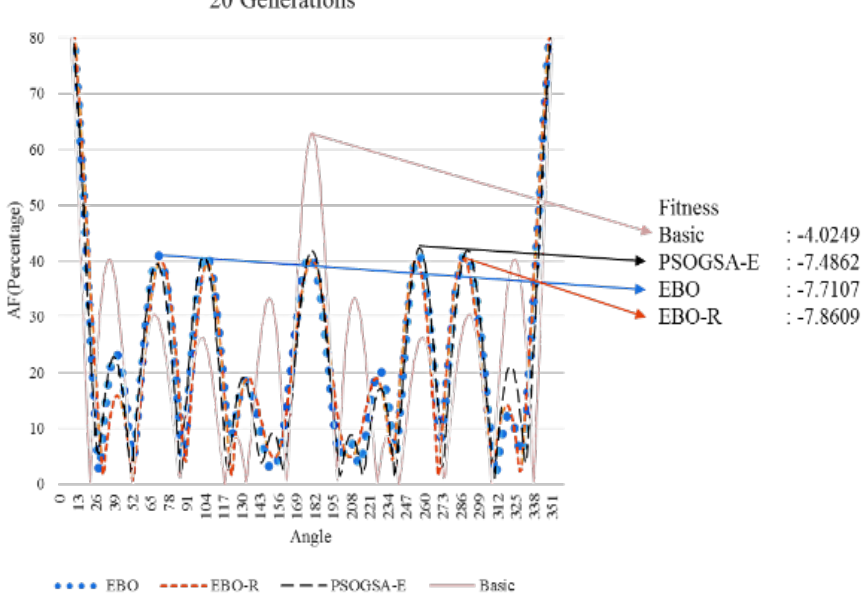
Figure 9. Beam patterns of different algorithms (20 generations).